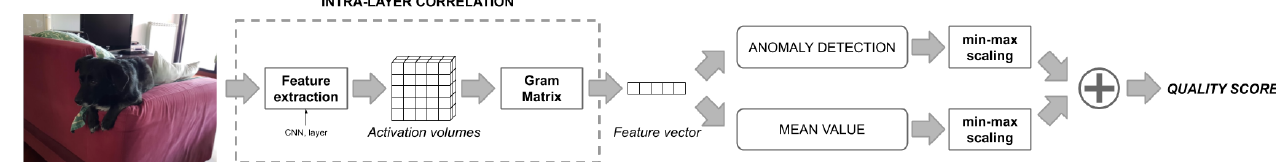
Figure 1. Schematic view of the proposed method. The intra-layer correlation is computed by the Gram matrix over the activation volumes of a Convolutional Neural Network (CNN). Then the abnormality and the average of the correlation are computed before applying the min-max scaling on both of them. In the end, the two metrics are summed resulting in the predicted image quality